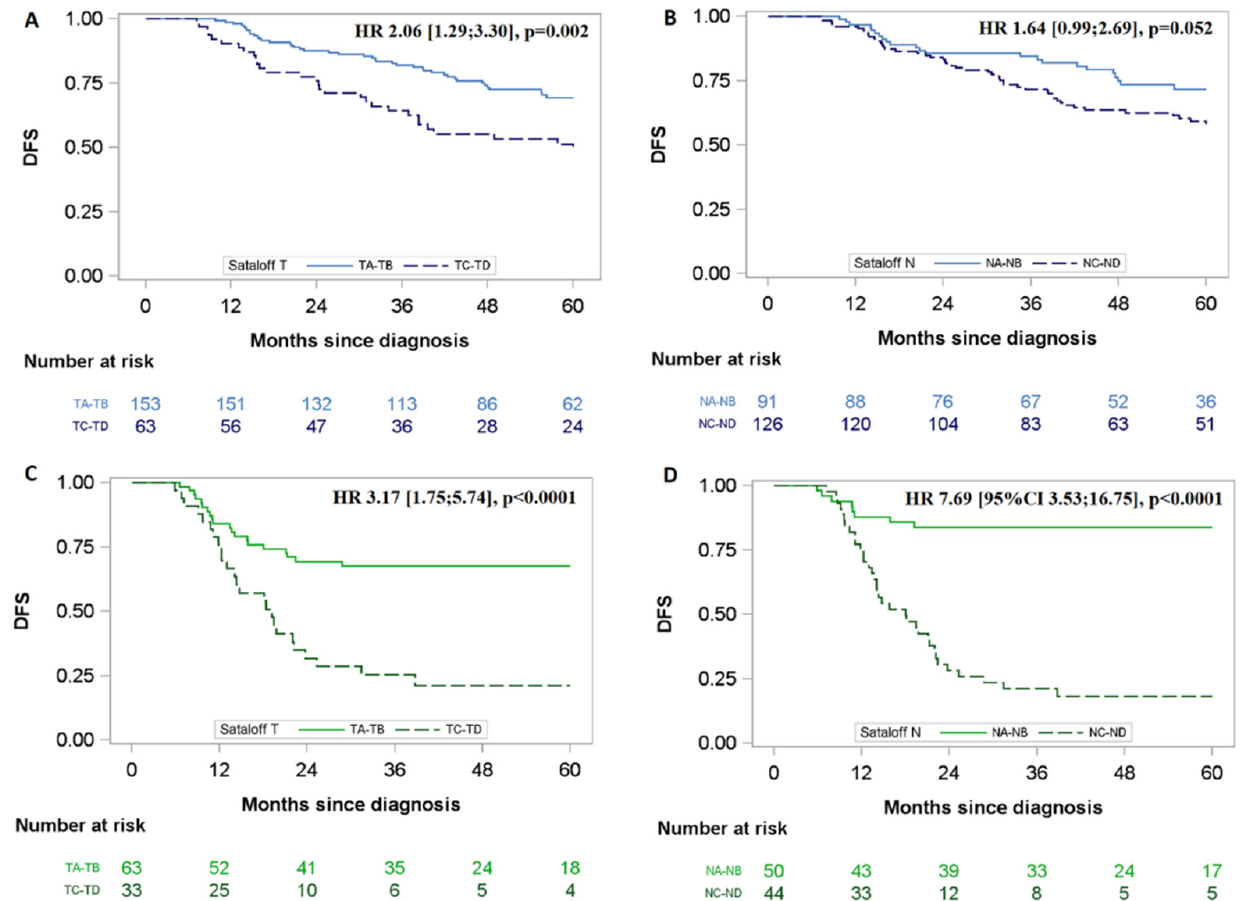
Figure 2. Association between DFS and Sataloff response by triple-negative status. The blue line corresponds to patients with HR+ and/or HER2+ tumours, whereas the green line corresponds to patients with triple-negative (TN) tumours. ( A ) Association between DFS and Sataloff TA-TB versus TC-TD response in patients with HR+ and/or HER2+ tumours: HR: 2.06 [95% CI: 1.29; 3.30], p = 0.002; ( B ) Association between DFS and Sataloff NA-NB versus NC-ND response in patients with HR+ and/or HER2+ tumours: HR: 1.64 [95% CI: 0.99; 2.69], p = 0.052; ( C ) Association between DFS and Sataloff TA-TB versus TC-TD response in patients with triple-negative tumours: HR: 3.17 [95% CI: 1.75; 5.74], p < 0.0001; ( D ) Association between DFS and Sataloff NA-NB versus NC-ND response in patients with triple-negative tumours: HR: 7.69 [95% CI 3.53; 16.75], p < 0.0001.